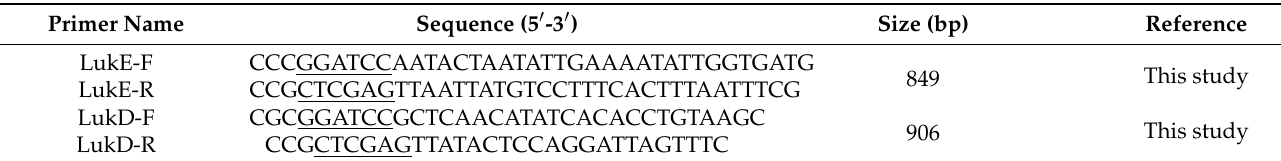
Table 3. The primers of lukE and lukD genes for